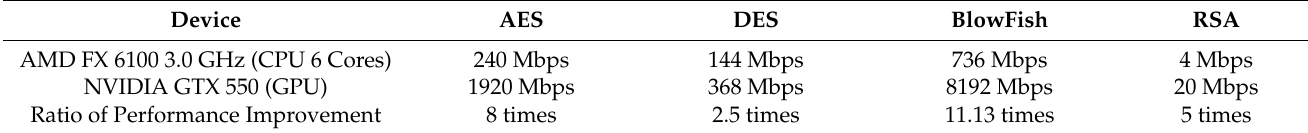
Table 5. Measuring cryptographic algorithm results using OpenCL